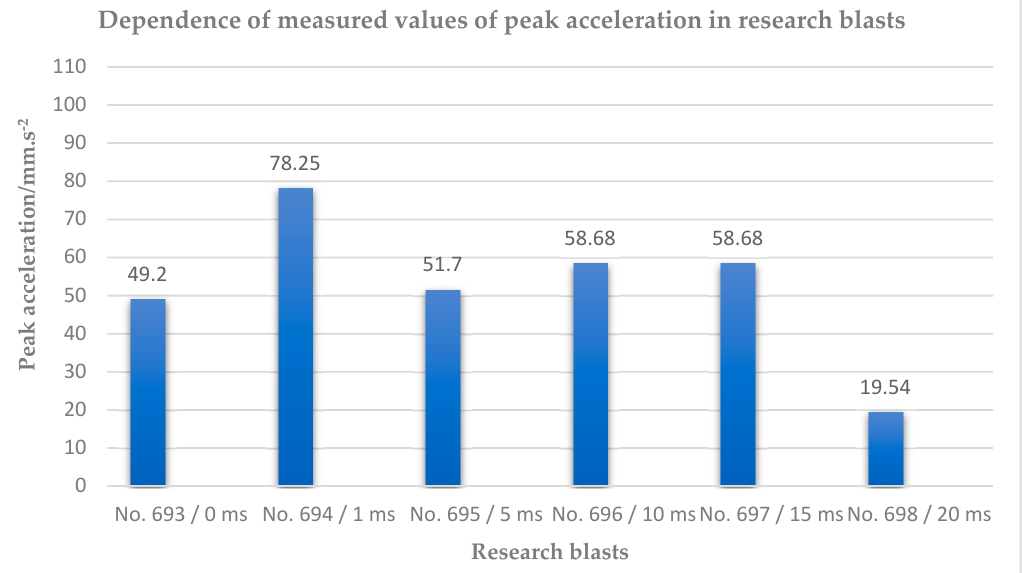
Table 7. Measured values of maximum particle velocities at individual delays of millisecond timing during daily aperture blasting in Trebejov Quarry [48].